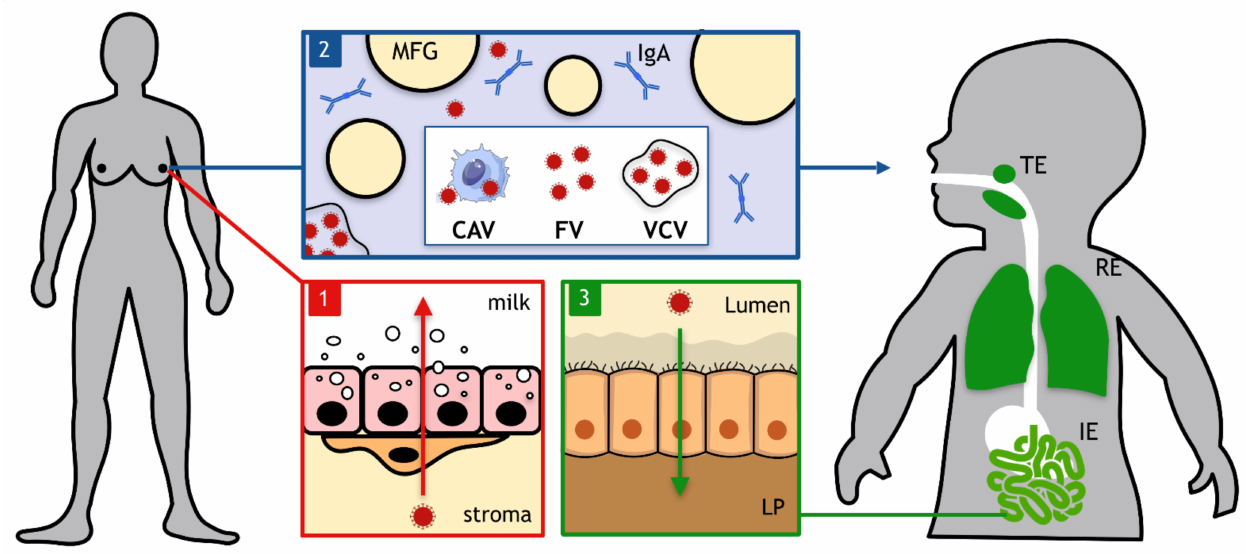
Figure 1. A chronology of the three main events occurring during viral mother-to-child transmission by breastfeeding. The first event consists of viral dissemination to mother’s mammary glands where viral infectious entities need to cross the mammary epithelium to be excreted in breast milk (red box). Then, viral infectious entities that could be either cell- associated viruses (CAVs), free viruses (FVs) or vesicle-cloaked viruses (VCVs) transit in breast milk in the presence of diverse components such as milk fat globules (MFGs) or immunoglobulins A (IgA). At this stage, conservation of viral infectivity needs to be ensured in breast milk (blue box). Finally, viral infectious entities can cross tonsillar (TE), respiratory (RE), and/or intestinal (IE) epithelia to infect the breastfed newborn. As an example, viral infectious entities present in the small intestine’s lumen need to cross the monostratified intestinal epithelium to reach the lamina propria (LP) (green